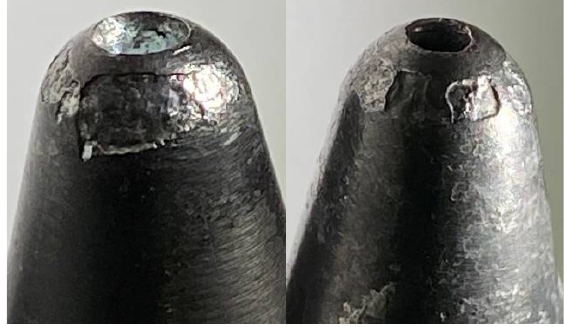
Figure 19. Failure mode of the ZIN injection contact zone by pitting.